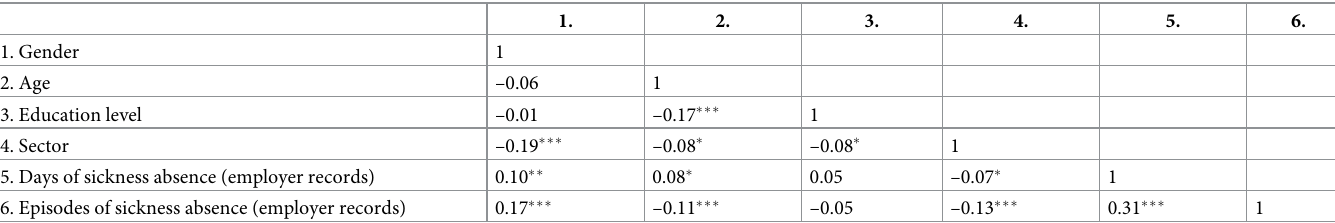
Table 4. Correlations between the main covariates in the employer records of sickness absence sample (n = 988).